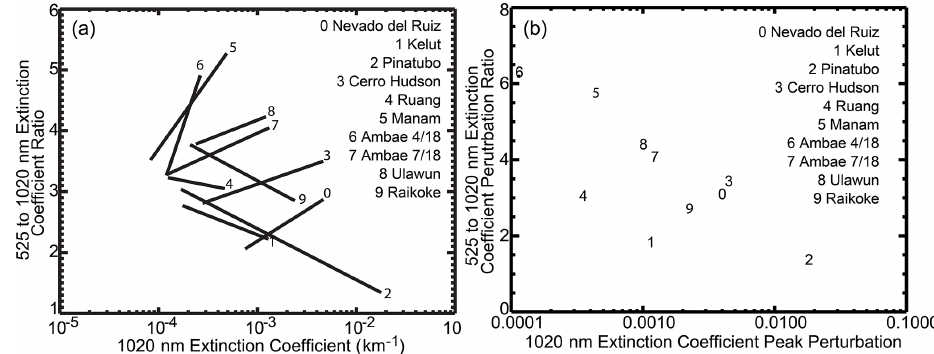
Figure 8. The “before” (left-hand point) to peak 1020nm aerosol extinction coefficient (right-hand point) for the 10 eruptions considered in this study is shown in panel (a) , and the differences between them (perturbations) are shown in panel (b)